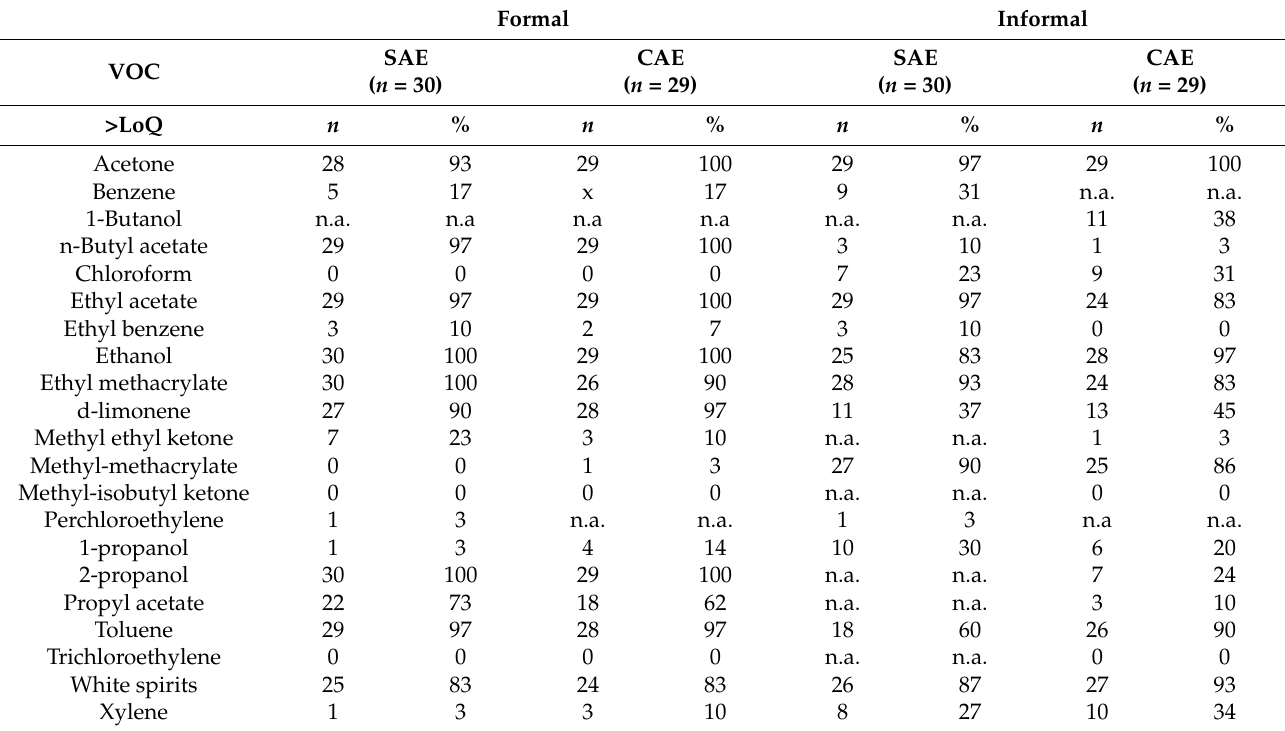
Table 1. Summary of VOCs analyzed and identified (>LoD) during SAE and CEA sampling campaigns.